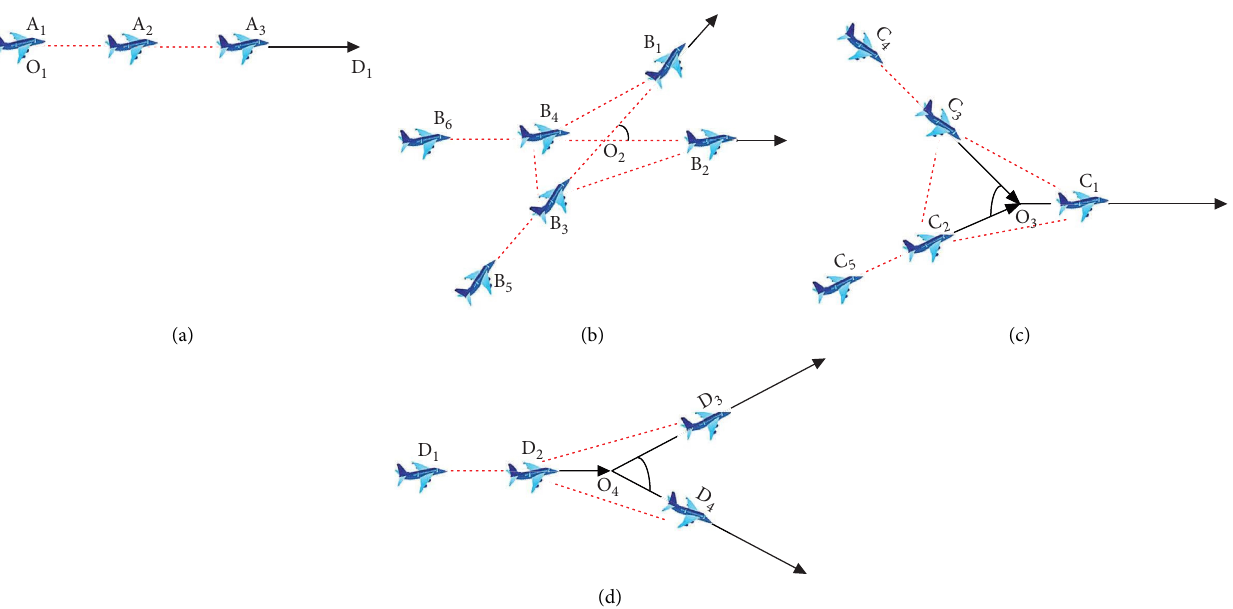
Figure 3: State of aircraft along diferent air routes. (a) Aircraft state along linear air routes. (b) Aircraft state along cross-air routes. (c) Aircraft state along convergent air routes. (d) Aircraft state along divergent air